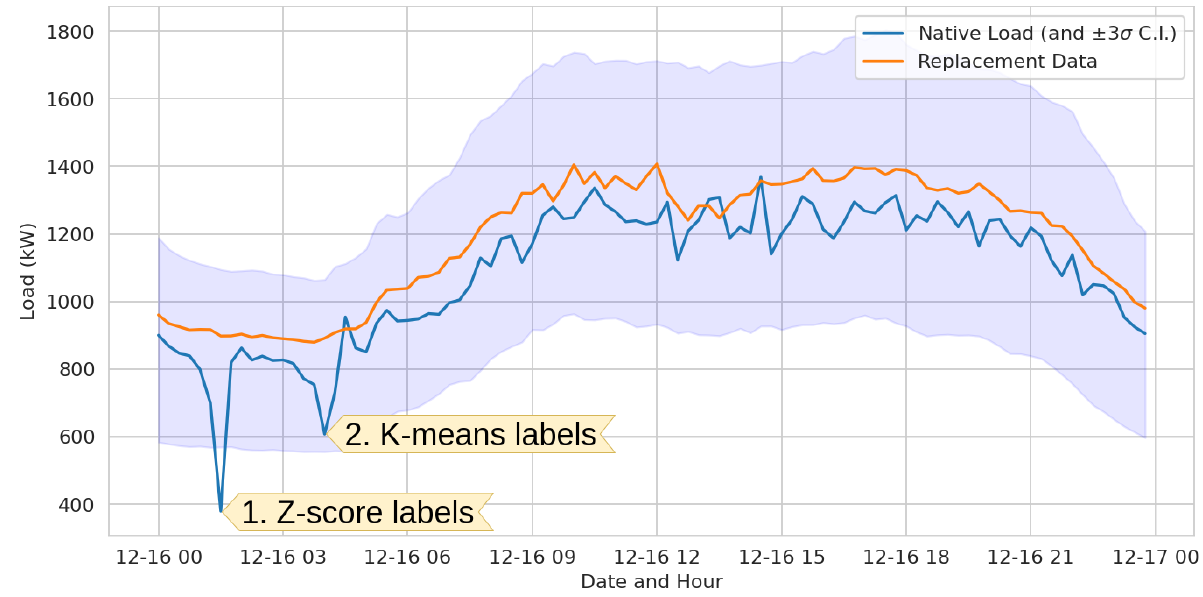
Figure 8. Z-score labels statistical outliers, for instance (1) is more than three standard deviations from the mean of all measurements from 1:00–1:45 on Sundays. Then k-means clustering labels geometrically close points, such as (2). The two outlier measurements are replaced with the corre- sponding values in Replacement Data, which come from 7-day naive persistence according to Table 2. Only the two data points are replaced (the Replacement Data curve is shown for